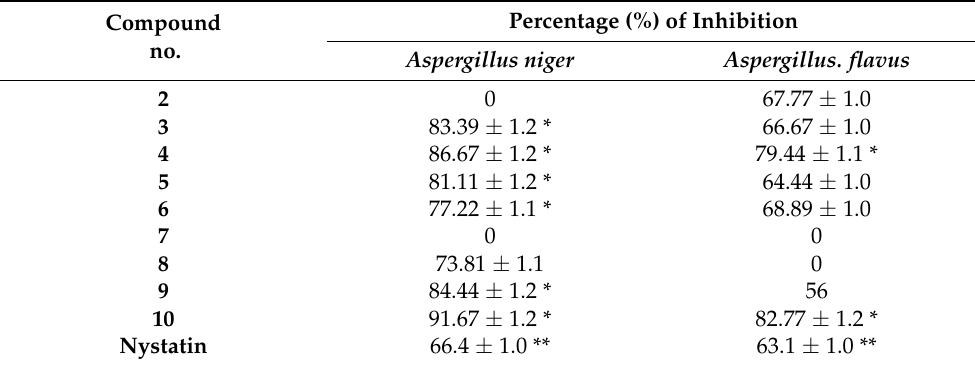
Table 3. Antifungal activities of the synthesized test analogs in (%) of inhibition. Compound